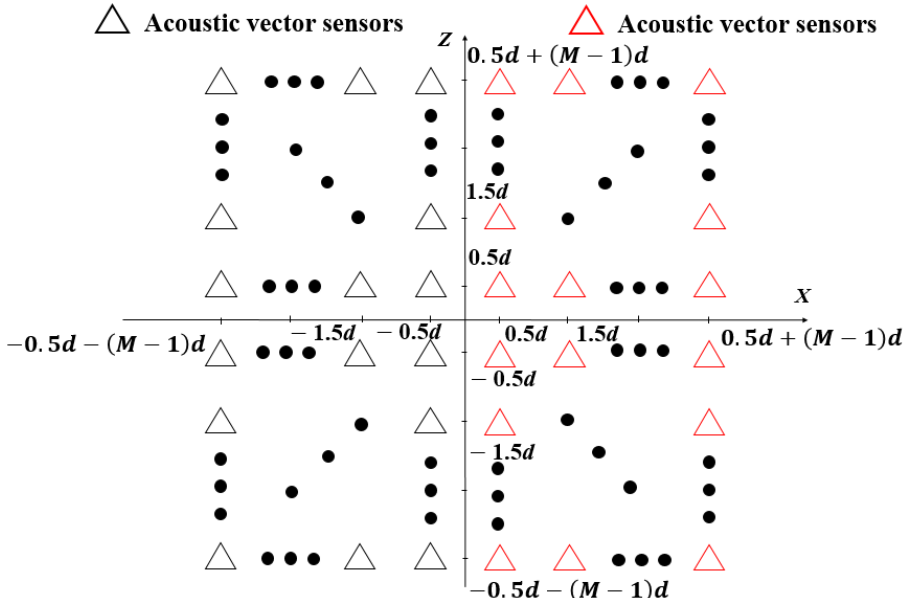
Figure 4. Virtual URA with Acoustic Vector Sensors in XZ